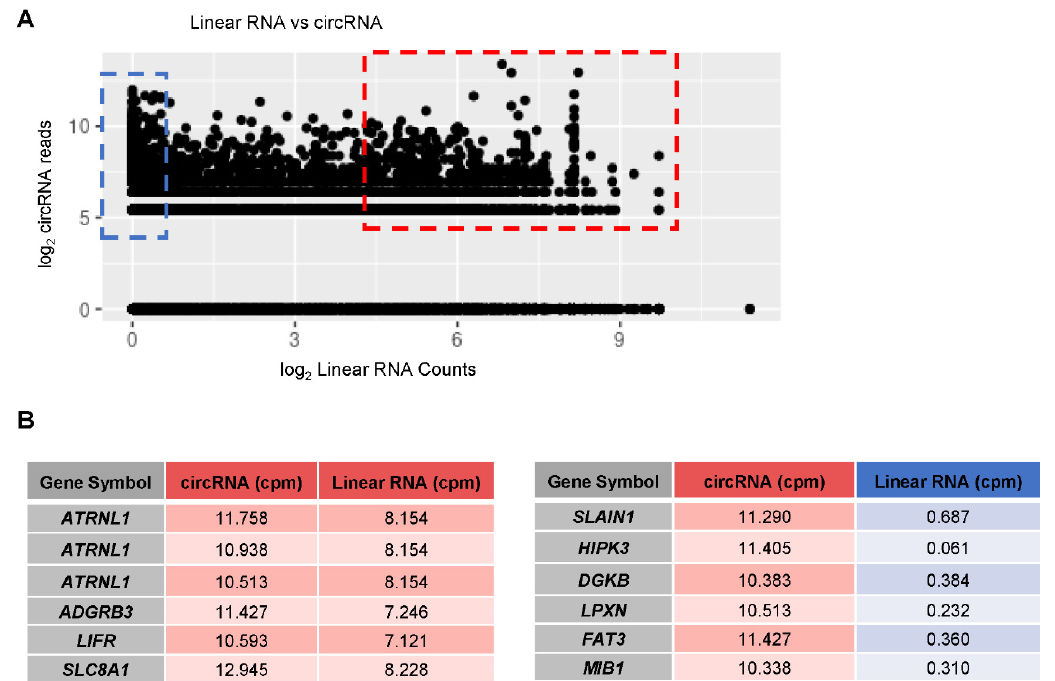
Figure 8. Linear vs. circRNA correlation plot. ( A ) Representative comparison of the number of circRNAs and linear reads from a single sample (GSE53697) to illustrate the lack of overall correlation seen between the expression of circRNAs and linear RNAs (r = 0.024). ( B ) Specific examples of parent genes that produce either high circRNA reads and high linear counts (inside the red box) or high circRNA reads and low linear counts (inside the blue box).